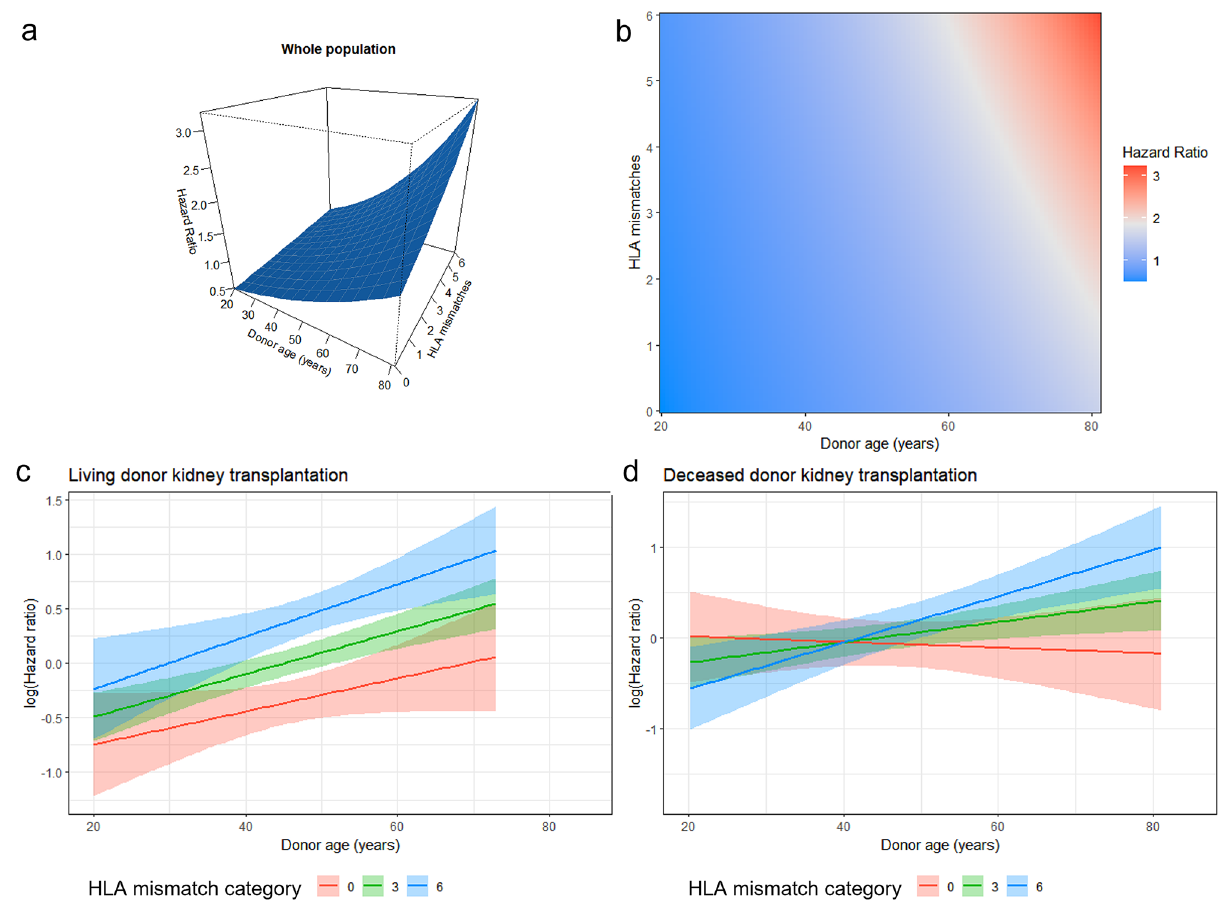
Figure 3. Hazard ratios of donor age to post-transplantation acute rejection within 1 year. ( a ) Three dimensional visualization of hazard ratio of donor age according to HLA mismatch numbers in overall study population ( b ) Two dimensional contour map of the hazard ratio of donor age according to HLA mismatch numbers in overall study population ( c ) Stratified hazard ratio of donor age in living donor kidney transplantation subpopulation ( d ) Stratified hazard ratio of donor age in deceased donor kidney transplantation subpopulation. Red line indicates logarithm of hazard ratio of donor age in HLA full match group. Each colored area indicates its 95% confidence interval. Green line indicates logarithm of hazard ratio of donor age in moderate HLA mismatch group (as representative, hazard ratio line of HLA mismatch number 3 is used). Blue line indicates logarithm of hazard ratio of donor age in high HLA mismatch group (hazard ratio line of HLA mismatch number 6 is used). All graphs are the results of multivariable regression analyses which included donor age, HLA mismatch numbers, desensitization, recipient sex, recipient age, donor hypertension, recipient blood pressure, deceased donor, duration of renal replacement therapy, ever smoking in